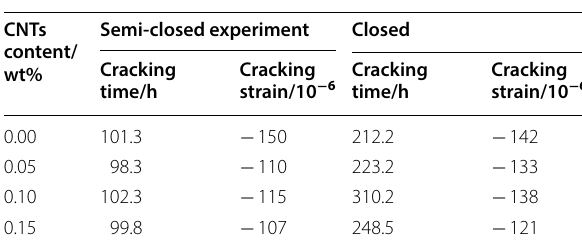
Table 8 Cracking indicators of cement mortar with